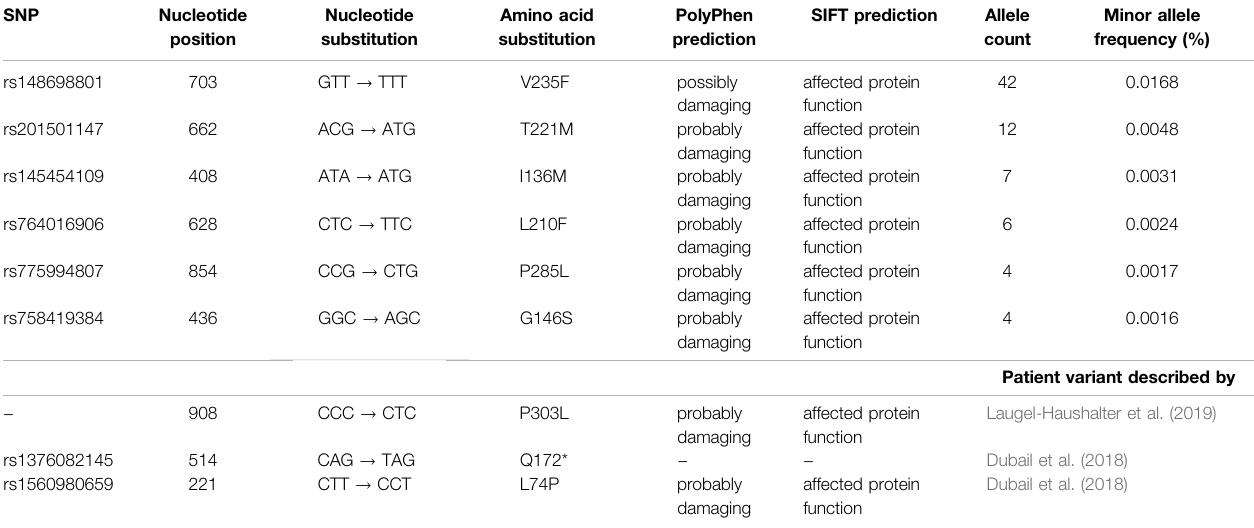
TABLE 4 | Overview of the analyzed SLC10A7 variants and their predicted effects on protein function. Minor allele frequencies are indicated. The last three variants listed were described in earlier studies (Dubail et al., 2018; Laugel-Haushalter et al., 2019). L74P served as a control in the present study, and P303L has not yet been functionally